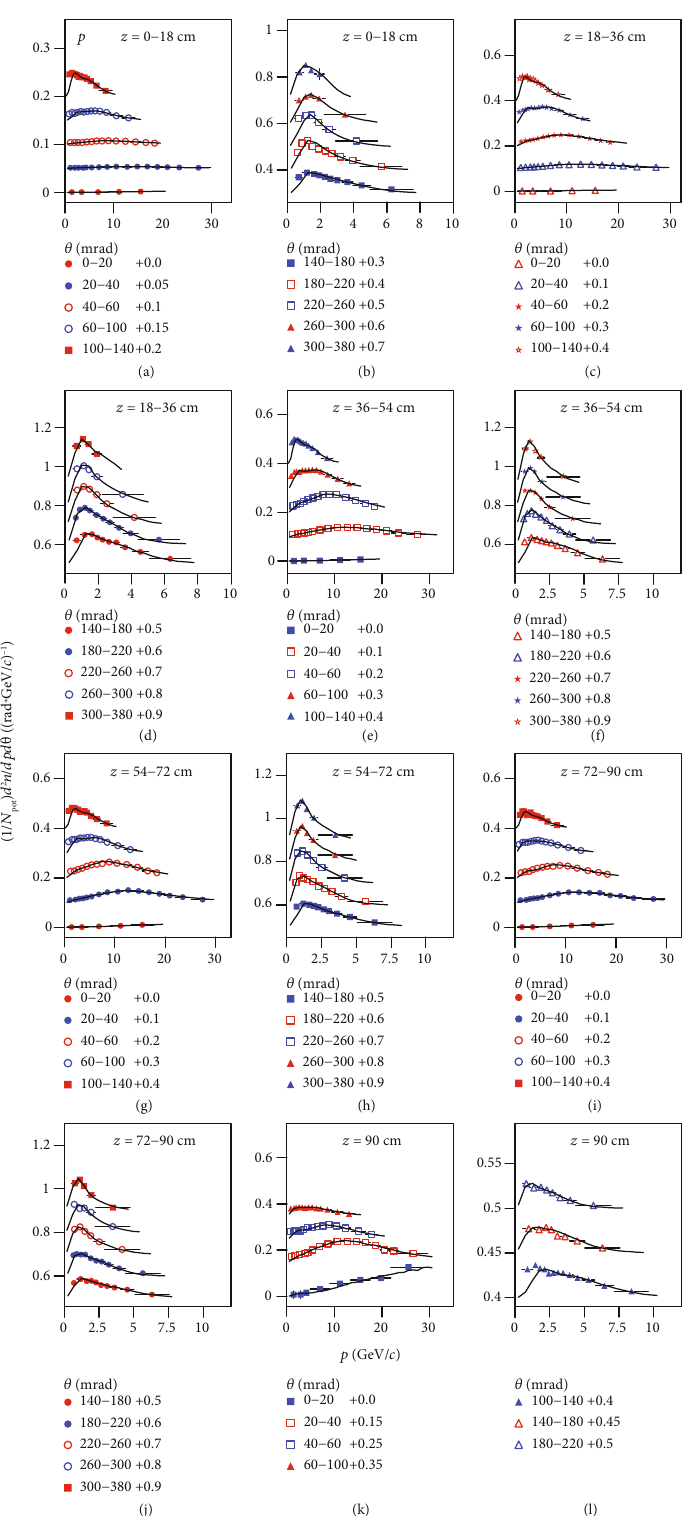
Figure 6: Same as Figure 1 but showing the spectra of p . Panels (a, b), (c, d), (e, f), (g, h), (i, j), and (k, l) represent the spectra for z = 0 – 18, 18 – 36, 36 – 54, 54 – 72, 72 – 90, and 90cm,